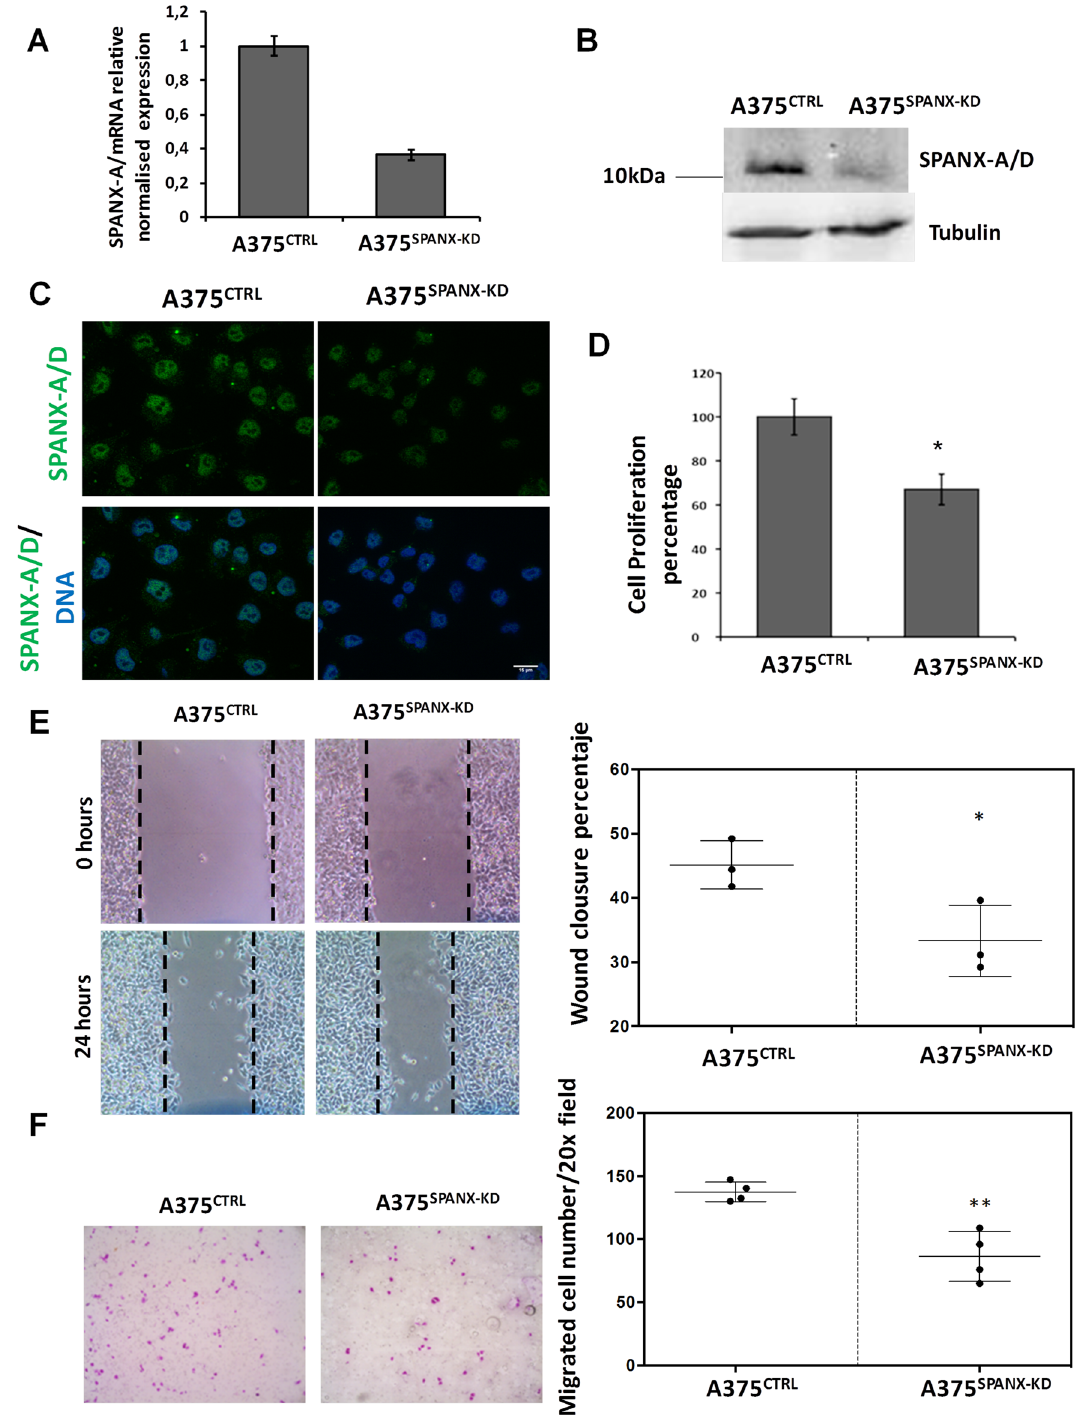
Figure 2. Role SPANX- A/D protein family in proliferation, motility and migration of A375 human melanoma cell line. Silencing of SPANX-A/D (A) at mRNA level by RT-qPCR assays (B) at protein level by western blotting (Crop from Supplementary Fig. S3) and (C) immunocitochemistry assays after transfecting A375 cells with shRNA targeting SPANX-A/D (A375 SPANX-KD ). A375 CTRL represent cells transfected with scramble shRNA. The nuclei were stained with Hoechst and are represented in blue. Scale bar 15 μm. (N = 3). Effect of the A375 cells transfected with shRNA SPANX-A/D in (D) Cell proliferation. Results are presented as the percent proliferation comparing A375 CTRL vs A375 SPANX-KD cells. Images were evaluated using ImageJ software (1.48v) (E) Cell migration. Photographs were taken at T = 0 to use them as initial wound area and after 24 h of incubation (T = 24 h), using inverted light microscope. Results are presented in a graph as wound closure percentage comparing A375 CTRL vs A375 SPANX-KD cells. The closed area was calculated using the ImageJ software (1.48v) by means of initial wound area at T = 0–T = 24. (F) Cell Trans-well migration. The results are expressed as the average of total number of migrated cells in 20 × field and compared A375 CTRL vs A375 SPANX-KD cells. The number of invading cells was quantified by counting stained cells in random fields of the membrane. The data shown in graphs (D) , (E) and (F) correspond to the mean of three independent experiments, and error bars indicate the SEM. *P < 0.05; **P < 0.01 (Students